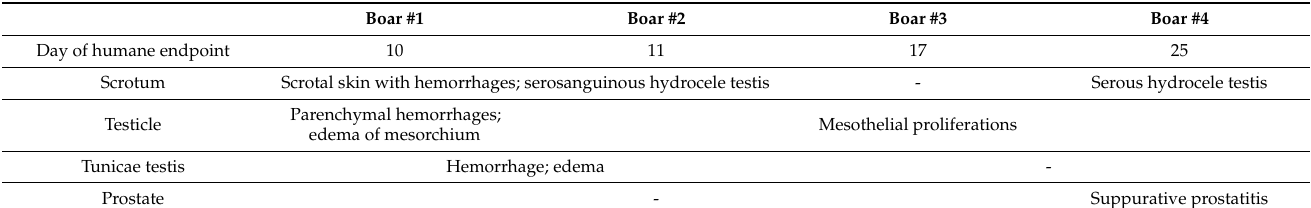
Table 1. Gross pathological findings of reproductive organs detected in ASFV-infected mature domestic breeding